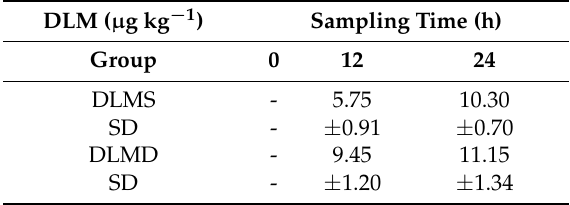
Table 5. Mean ± SD of DLM residue ( µ g kg − 1 ) in goat cheese elaborated with pooled milk (groups of 7 animals each) following pour-on DLM sheep dose (DLMS-group) and DLM sheep double dose (DLMD-group)